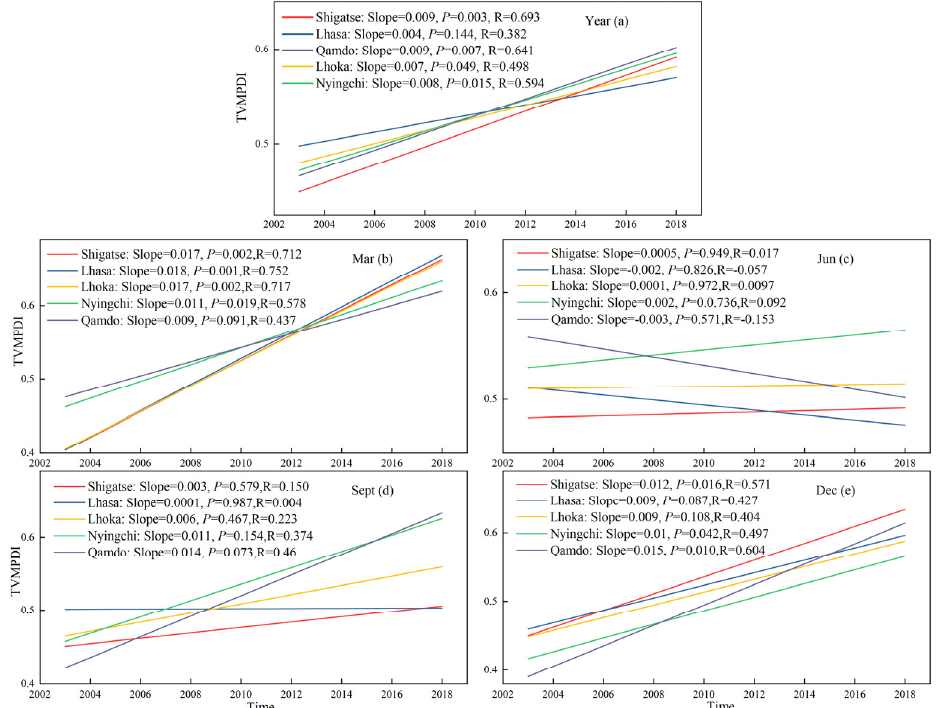
Figure 6. Interannual variation of the TVMPDI in five regions of the study area: ( a ) interannual variation; ( b ) variation in March; ( c ) variation in June; ( d ) variation in September; ( e ) variation in December.